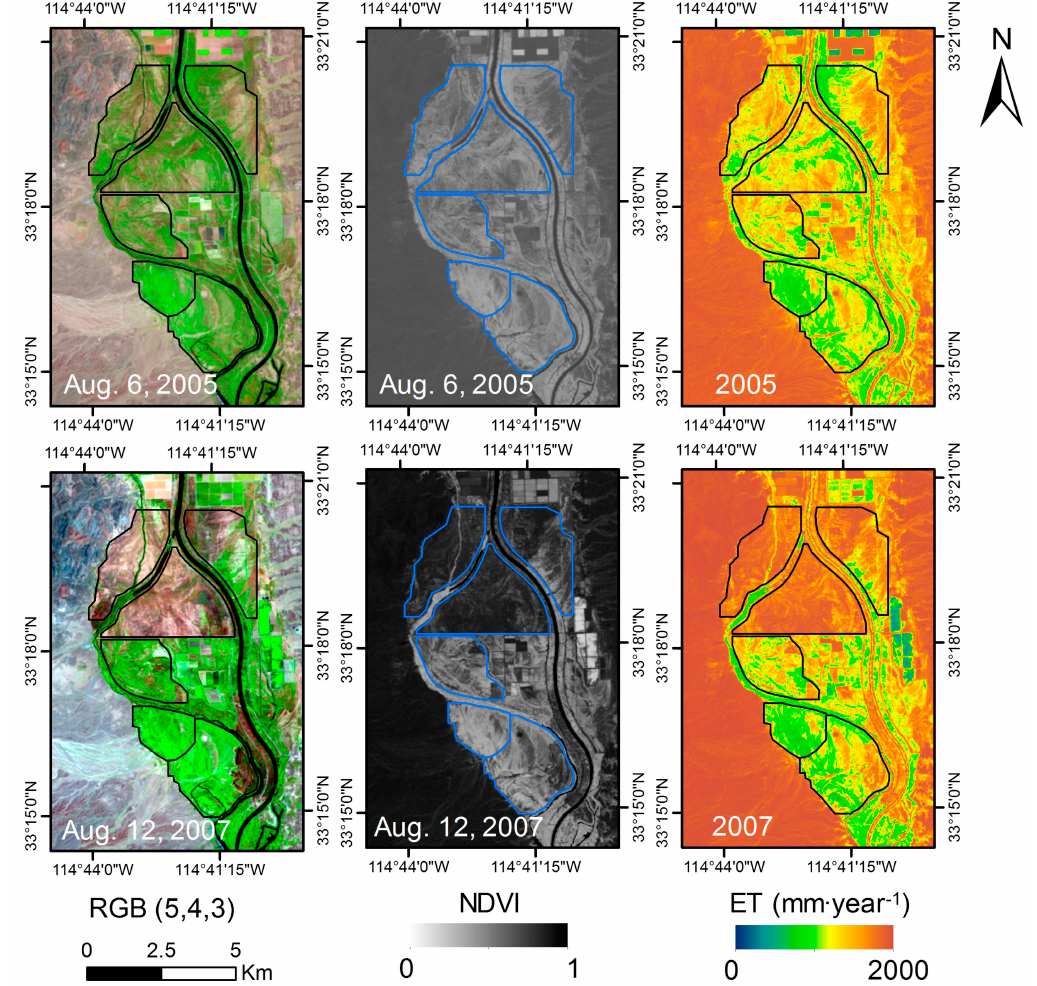
Figure 10. Landsat false color composite, NDVI, and annual ET before ( top ) and after ( bottom ) the wildfire of 2006.